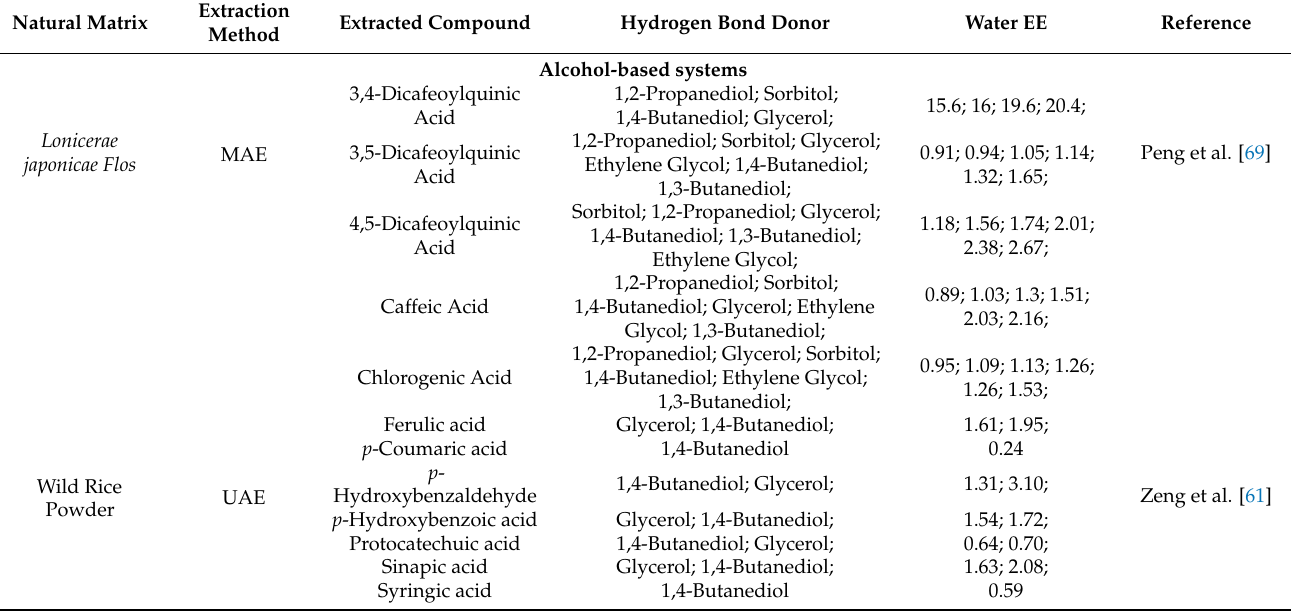
Table 4. Correlation between the natural matrix, extraction method, and DES based on ammonium salts (choline chloride and betaine) and the effect of different HBDs on the extraction efficiency of different phenolic acids compared with water